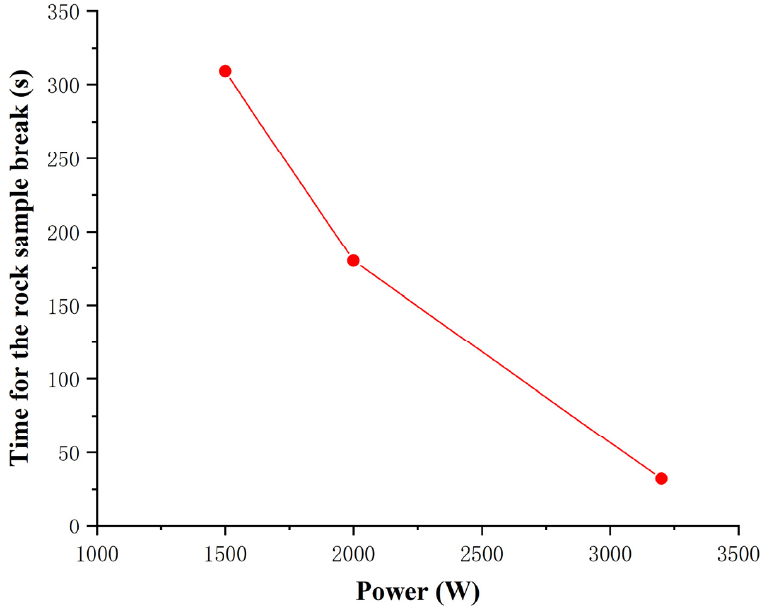
Figure 3. Variation curve of average rupture time of rock samples under different powers.